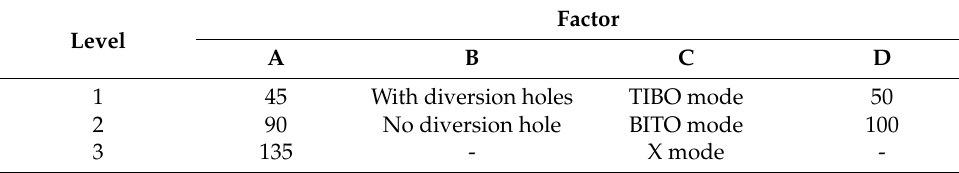
Table 2. Orthogonal experiment combination.